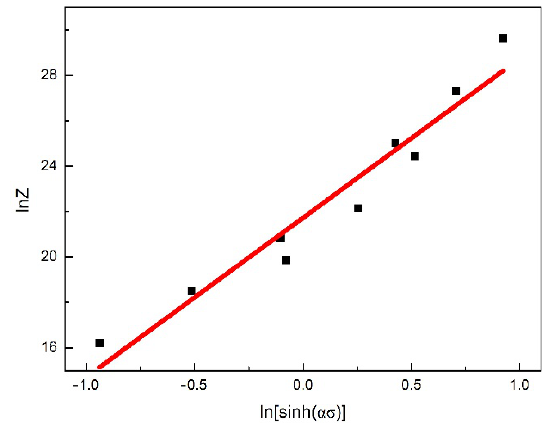
Figure 5. The relationship between lnZ and ln[ sinh (ασ)].